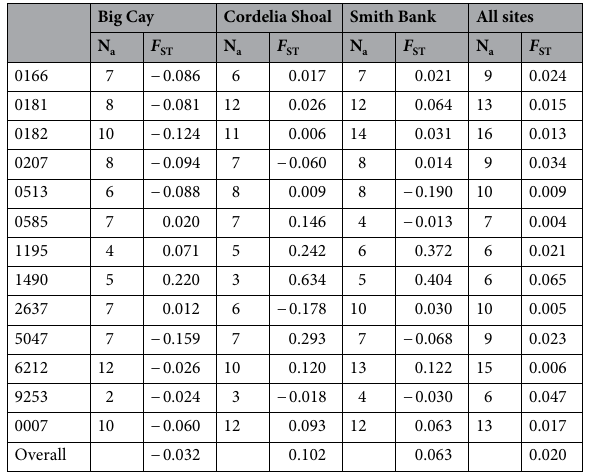
Table 2. Genetic diversity at 13 microsatellite loci for Acropora cervicornis for the three sample sites of Cordelia Bank Site of Special Importance to Wildlife. Only one representative of each clonal genotype is included in the analysis. N a , number of alleles; F ST , Fixation coefficient.